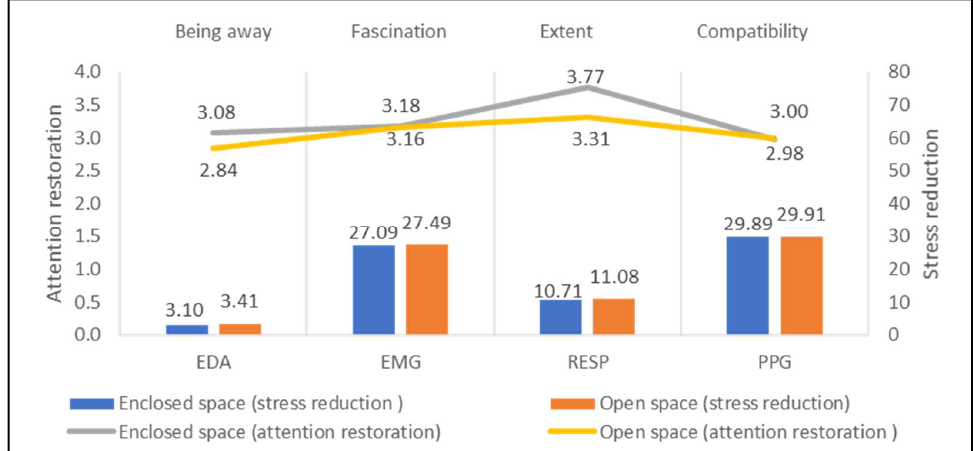
Figure 6. Impacts of space openness on stress recovery and attention restoration.